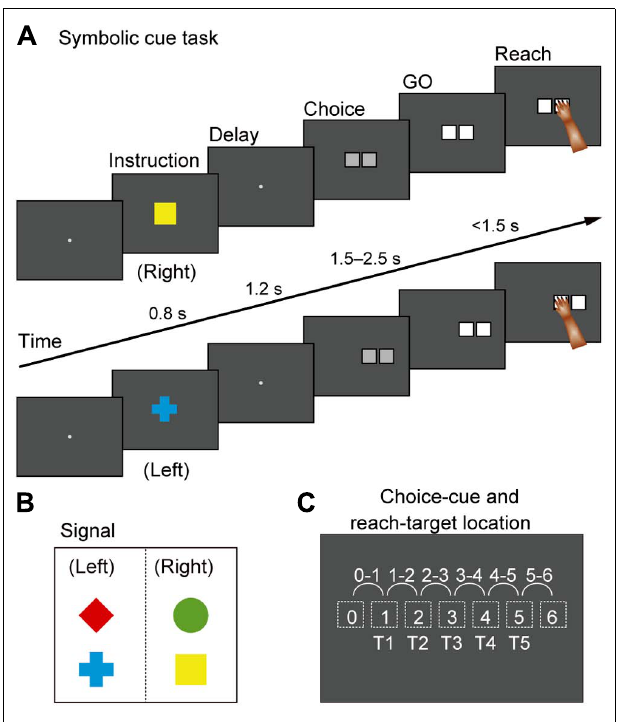
FIGURE 6 | Symbolic cue task. (A) Temporal sequence of behavioral events in the symbolic cue task. If the monkey continued to gaze at the fixation point for 1,200 ms, a cue was randomly presented for 800 ms to signal the animal to select either the right or the left target (i.e., the behavioral goal). A green circle and a yellow square signaled selection of the target on the right, whereas a red diamond and a blue cross indicated that the left target should be selected (B) . Because no information about future targets was available at this stage, the monkeys were required to select right or left without specifying a forthcoming action. If the monkey continued to gaze at the fixation point for 1,200 ms during the subsequent delay, a choice cue consisting of two gray squares appeared at one of six different locations on the screen (C) . At this point, the animal could specify what to do (i.e., action) for the first time. After 1,500–2,500 ms, the color changed from gray to white (the GO signal). If monkeys reached for the target with their right arm, they received a fruit juice reward 500 ms after touching the correct square. (B) Visual signals used to designate selection of left or right in the forthcoming choice cue. (C) Locations of the choice cue and target on the screen. For the choice cue, two gray squares appeared at neighboring positions (locations 0–6, depicted with dotted squares).The target position was selected from five potential targets (T1–T5) that were located on the left or the right of the choice cue.